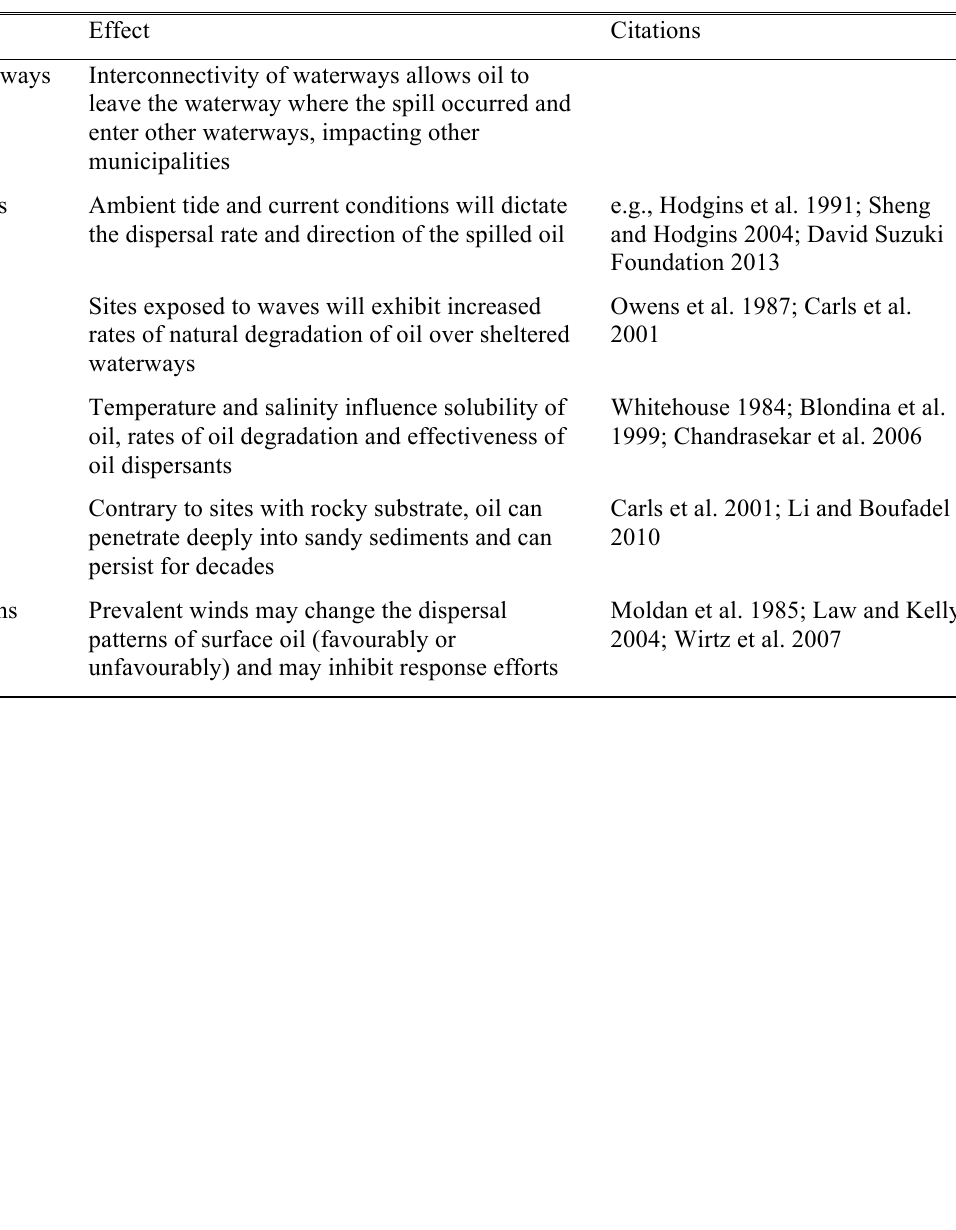
Table A1.3 Marine physical environment